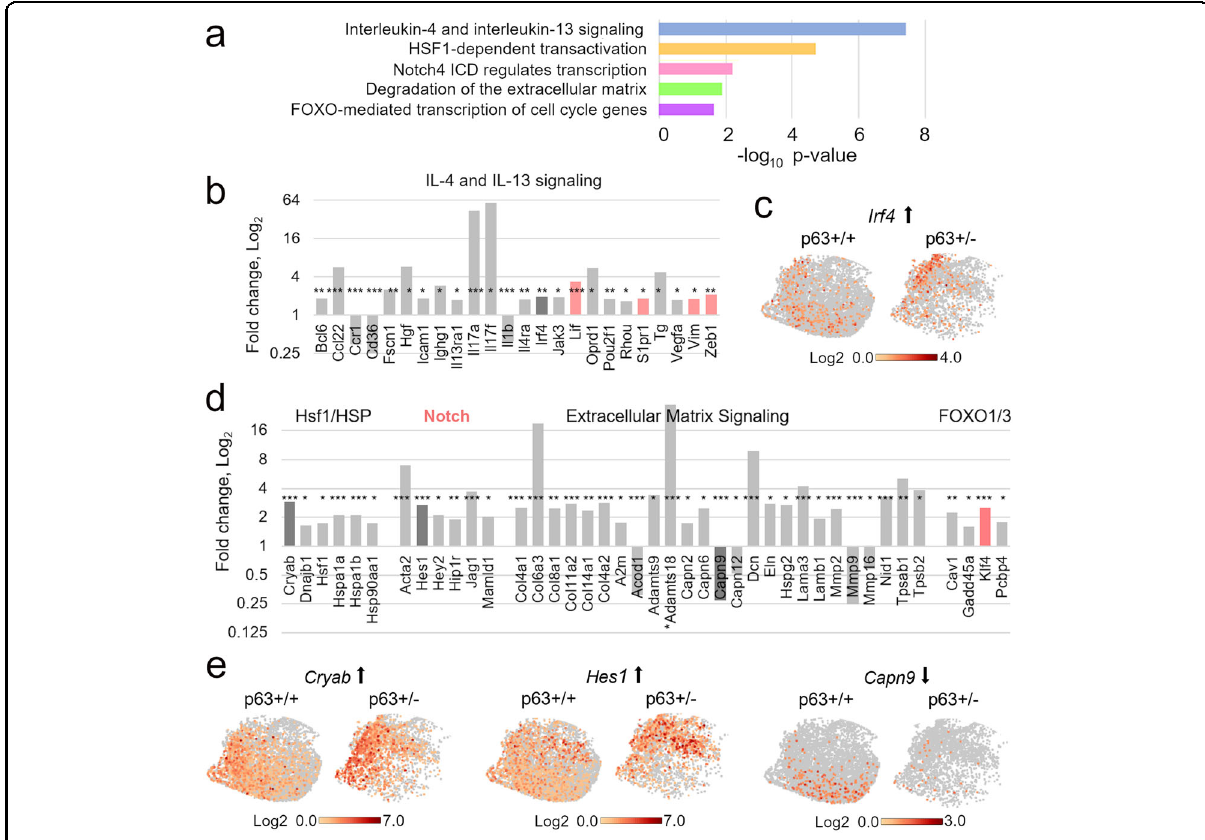
Fig. 4 Pathways signi fi cantly altered in p63 + / − vs. p63 + / + luminal mammary epithelial cells. a Representative pathways from the scRNA-seq analysis of the luminal p63 + / − vs. p63 + / + clusters (de fi ned as in Fig. 3b, c) revealed by the Reactome pathway analysis. See Supplementary Fig. 1 for the full list of enriched pathways. b – e Signi fi cantly altered genes in the individual pathways ( b , d ) and UMAP plots of selected genes ( c , e ). Dark gray bars, genes whose UMAP plots are shown; pink, stemness and self-renewal pathways and genes. * p < 0.05, ** p < 0.01, *** p <